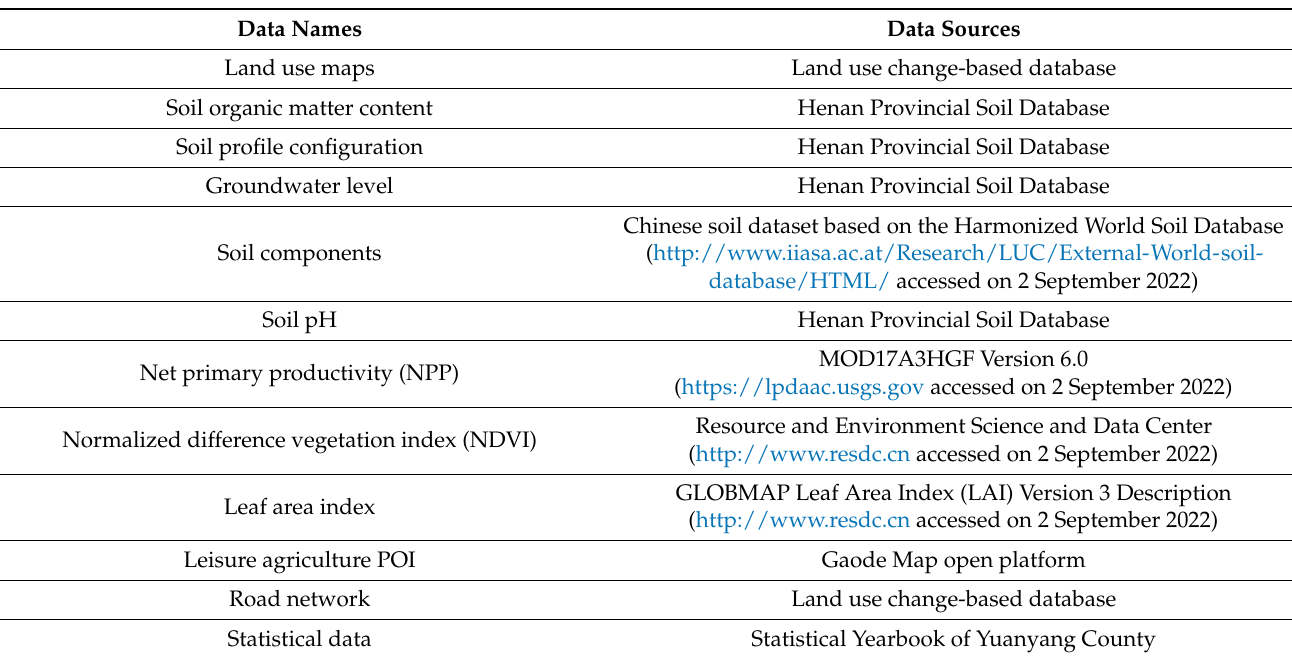
Table 4. Data description used for ecological security evaluation and CLUF